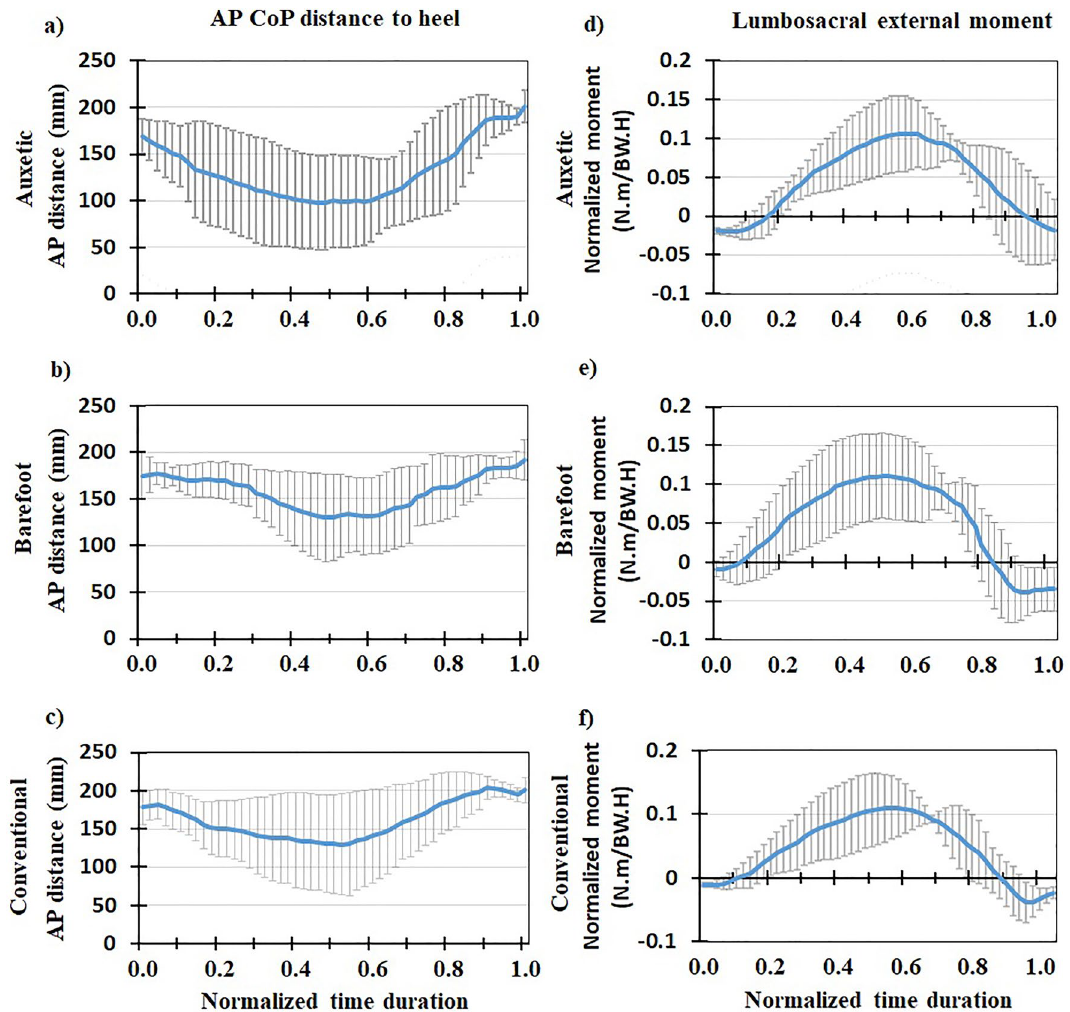
Figure 10. (Left) AP distance between CoP of GRF and heel (mm) (+ / − one standard deviation) during the FL phase of DVJ in three footwear conditions: ( a ) auxetic shoe, ( b ) barefoot, and ( c ) conventional shoe. (Right) mean normalized lumbosacral external moment (N m/BW H) (+ / − one standard deviation) during the FL phase of DVJ in three footwear conditions: ( d ) auxetic shoe, ( e ) barefoot, and ( f ) conventional